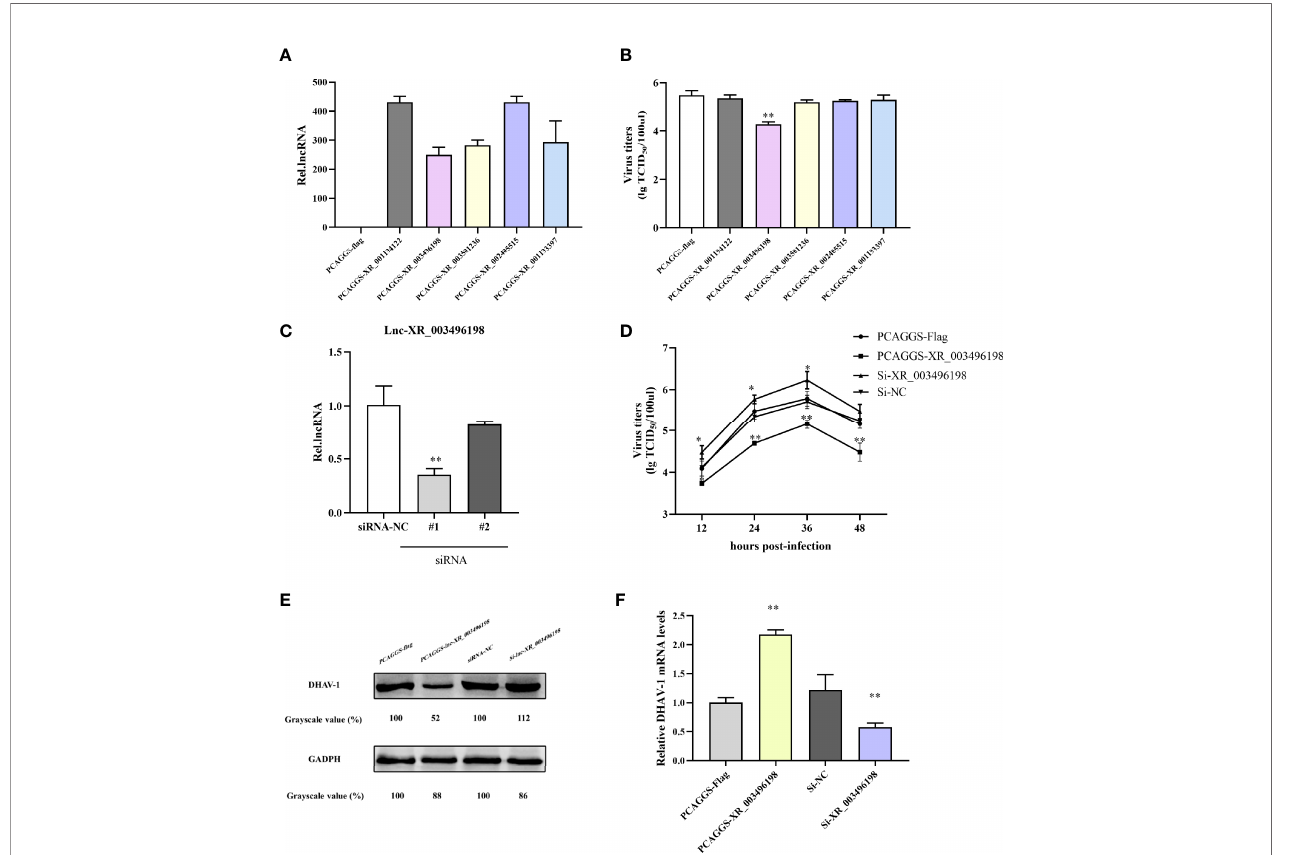
FIGURE 9 | (A) RT-qPCR detection of lncRNA overexpression plasmids transfection effects. DEFs were transfected with PCAGGS-lncRNA plasmids or PCAGGS- fl ag vectors. At 24 hpi, the DEFs were harvested for lncRNA expression detection. (B) lncRNA-XR_003496198 can inhibit DHAV-1 replication in DEFs. DEFs were transfected with lncRNA overexpression plasmids and then stimulated with pathogenic DHAV-1. At 24 hpi, the supernatant of DEFs was collected for virus titers detection. (C) DEFs were transfected with PCAGGS-XR_003496198, PCAGGS- fl ag plasmids or si-XR_003496198 or siRNA NC followed infected with DHAV-1. The supernatant of DEFs at different time points was collected for virus titers detection. (D) Virus replication was determined by the detection of DHAV-1 proteins. DEFs were transfected with PCAGGS-XR_003496198 or PCAGGS- fl ag plasmids, si-XR_003496198 or siRNA NC, followed infected with DHAV-1. After 24h infection, DEFs were used to assess the level of DHAV-1 protein replication. * indicated P < 0.05 and ** indicated P <